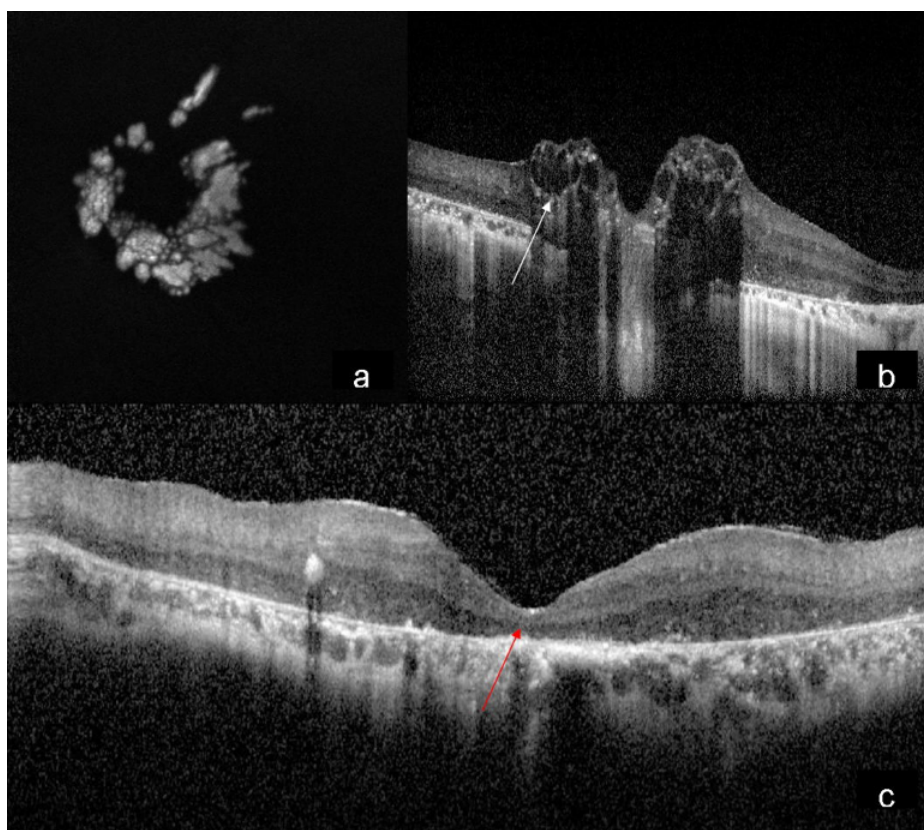
Figure 3: Autofluorescence of the left eye (a) showing typical hyperautofluorescence; SD-OCT showing moth eaten optically empty spaces (b) (white arrow) and hyperreflective dots along with foveal thinning (c) (red arrow)